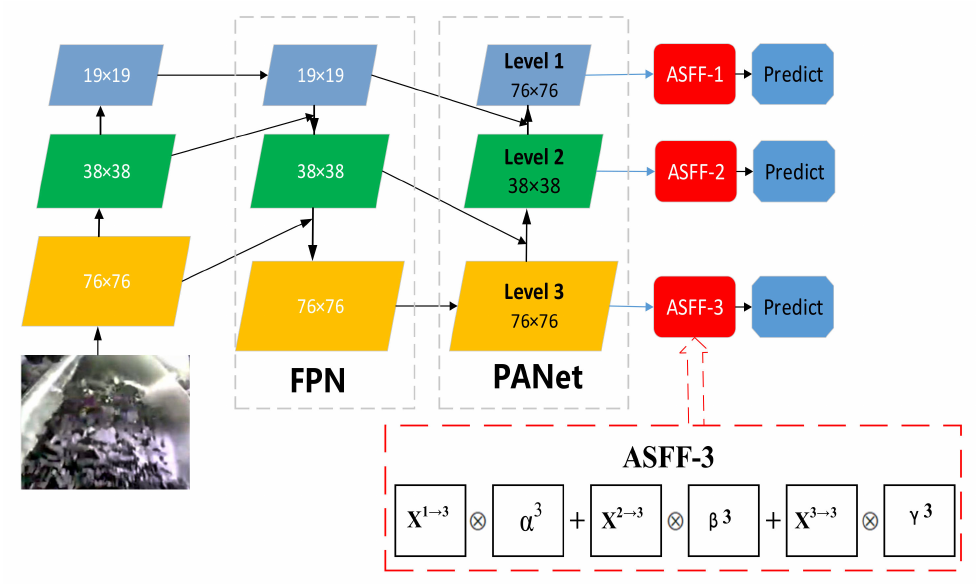
Figure 4. Structure diagram after adding